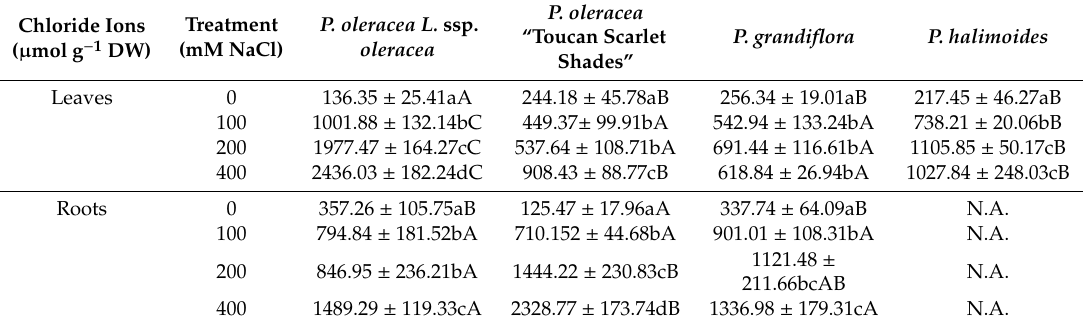
Table 2. Chloride ions’ concentration in roots and leaves and stems of the four investigated Portulaca genotypes undergoing 5 weeks of salt